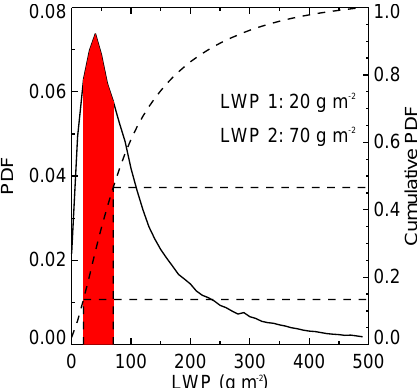
single-layer mid-level stratiform clouds from MODIS retrievals. The red area indicates the third of the cumulative distribution that is centered on the peak of the LWP PDF. Given in the figure is LWP 1, the value for the lower third, and LWP 2, the value at the upper